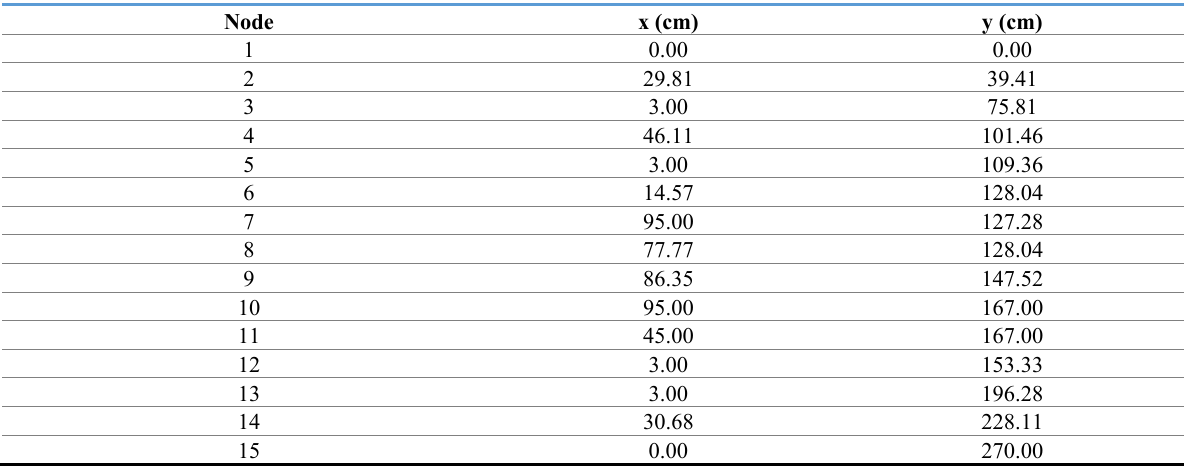
Table 2. Coordinates of truss model for f = 50%